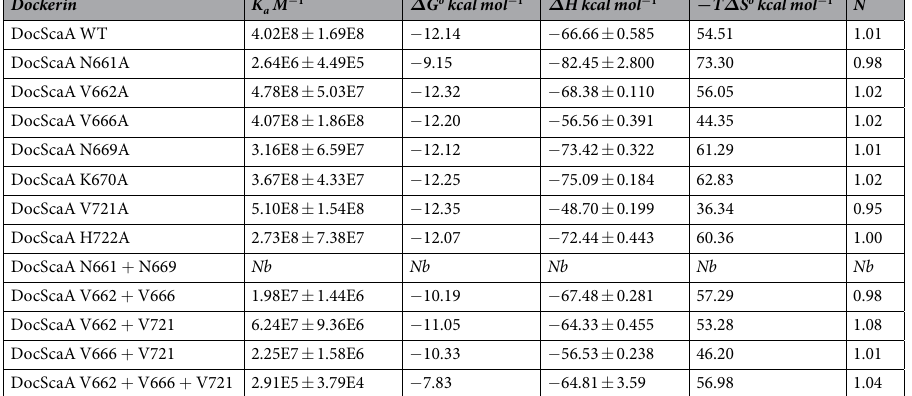
Table 3. Thermodynamics of interaction between wild type CohScaB5 and wild-type and mutant variants of ScaDocA. All thermodynamic parameters were determined at 308 K. Nb , no